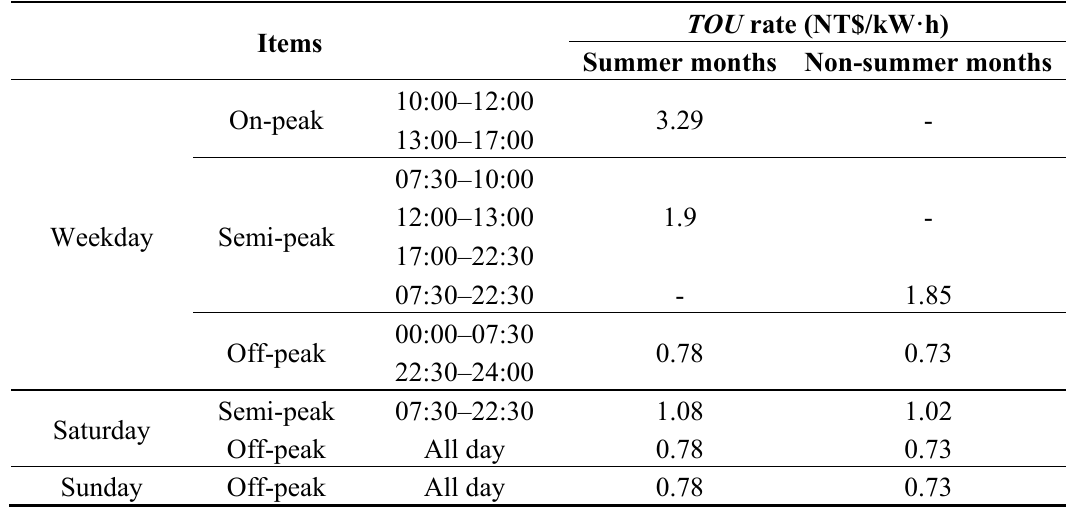
Table 8. Rate of purchasing electricity from the utility. TOU : time-of-use.